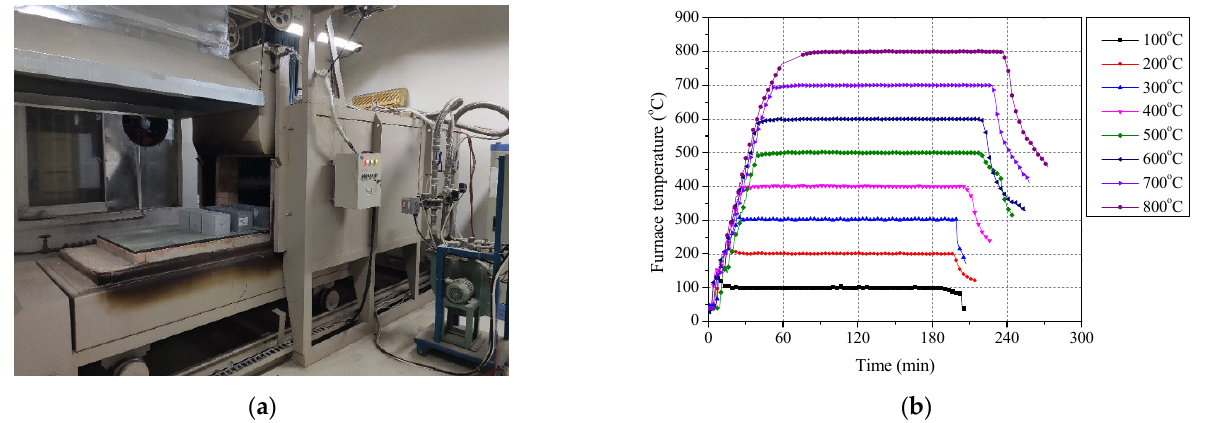
Figure 3. Heating system for concrete, mortar and paste: ( a ) furnace and ( b ) measured furnace temperature-time curves.